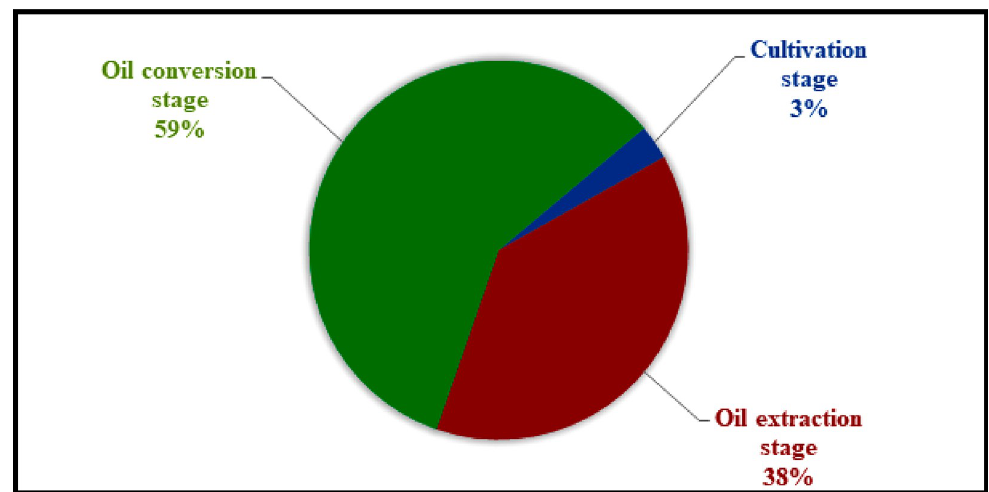
Fig 4. Percent energy consumption by JC biodiesel production